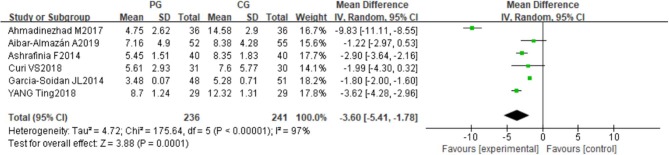
Meta-analysis and forest plot and for PSQI.